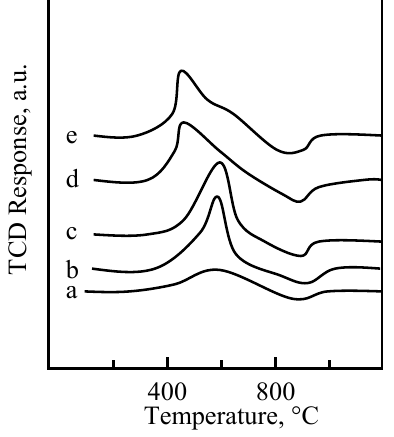
Figu re 6 . TPR spectra of the K/AC(C) samples with K loadings of ( a ) 0%, ( b ) 2.9%, ( c ) 5.8%, ( d ) 8.8%, and ( e ) 11.6% by weight,